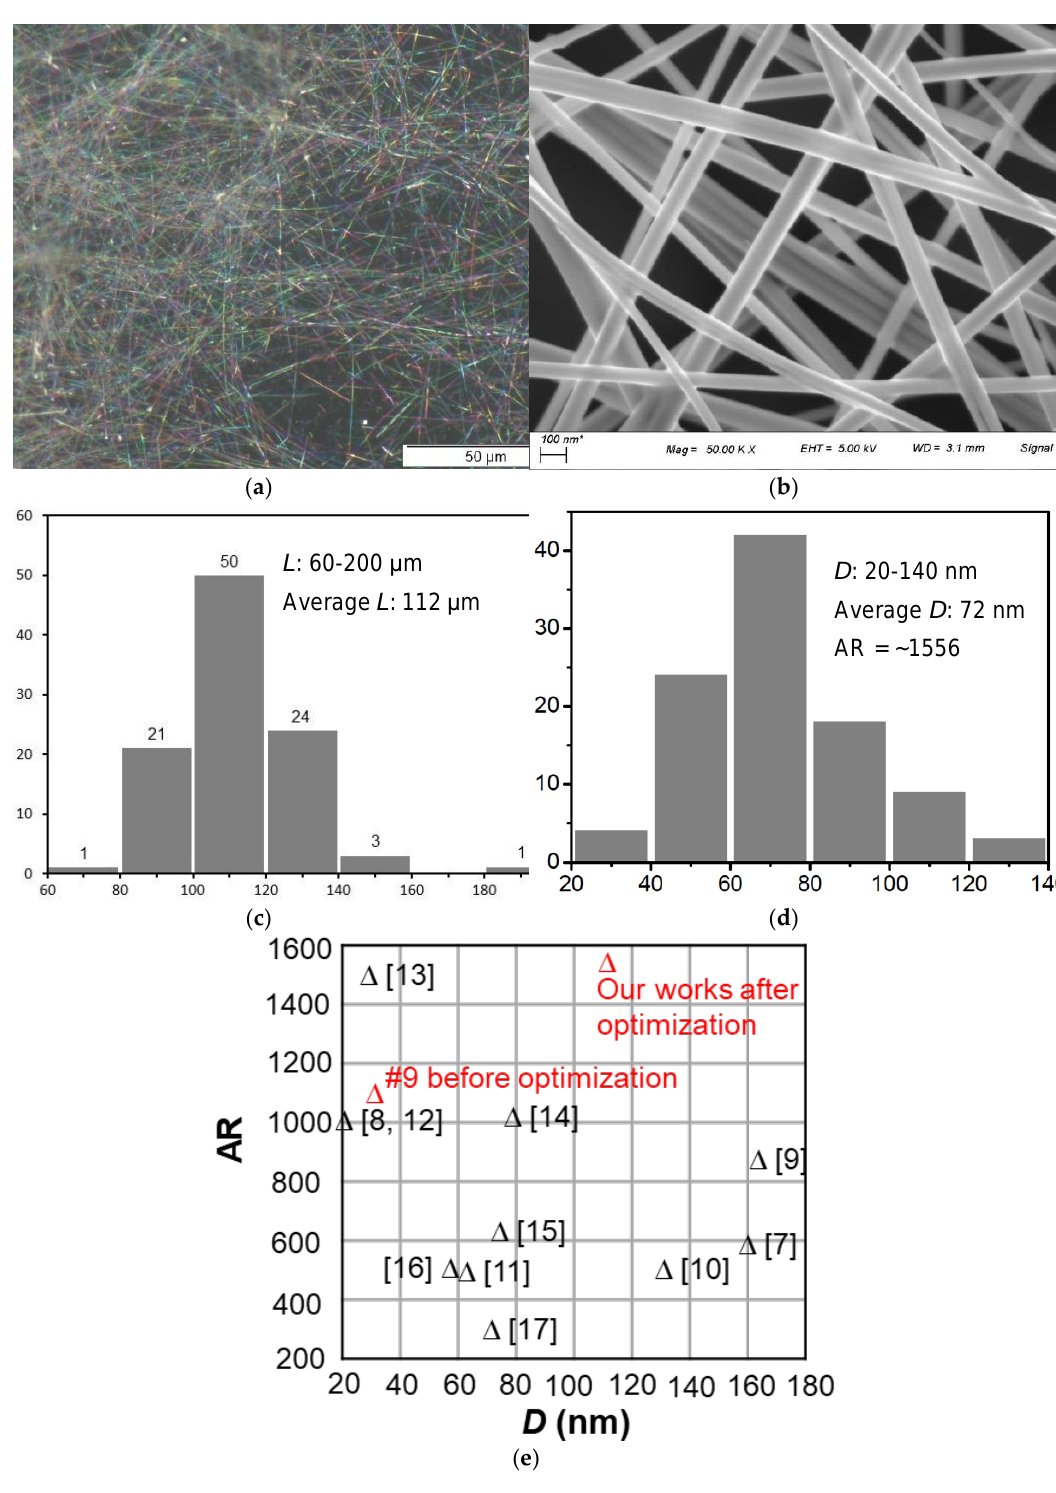
Figure 3. ( a ) Optical microscope and ( b ) Scanning Electron Microsopy images of the AgNW, ( c ) length and ( d ) diameter distribution of AgNWs synthesized at optimized synthesis conditions; ( e ) comparison of the AgNW AR of our works with other reported values of AgNW AR. It is necessary to emphasize that these AgNWs are those synthesized from the optimized batch, to distinguish themselves from the previous AgNWs synthesized as part of the Taguchi Design of Experiment, which also has AgNW diameter and length